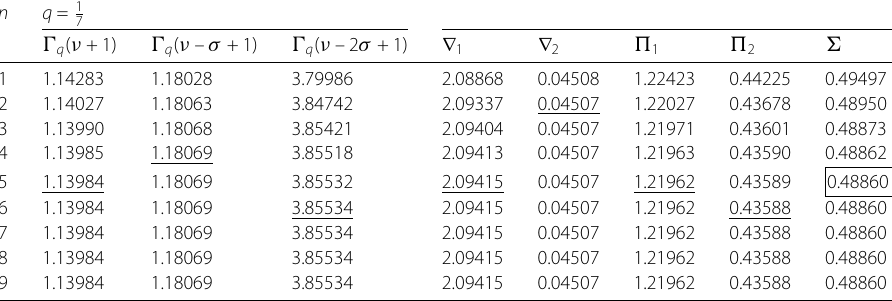
Table 1 Numerical results of ∇ 1 , ∇ 2 , (cid:14) 1 , and (cid:14) 2 for q = 1